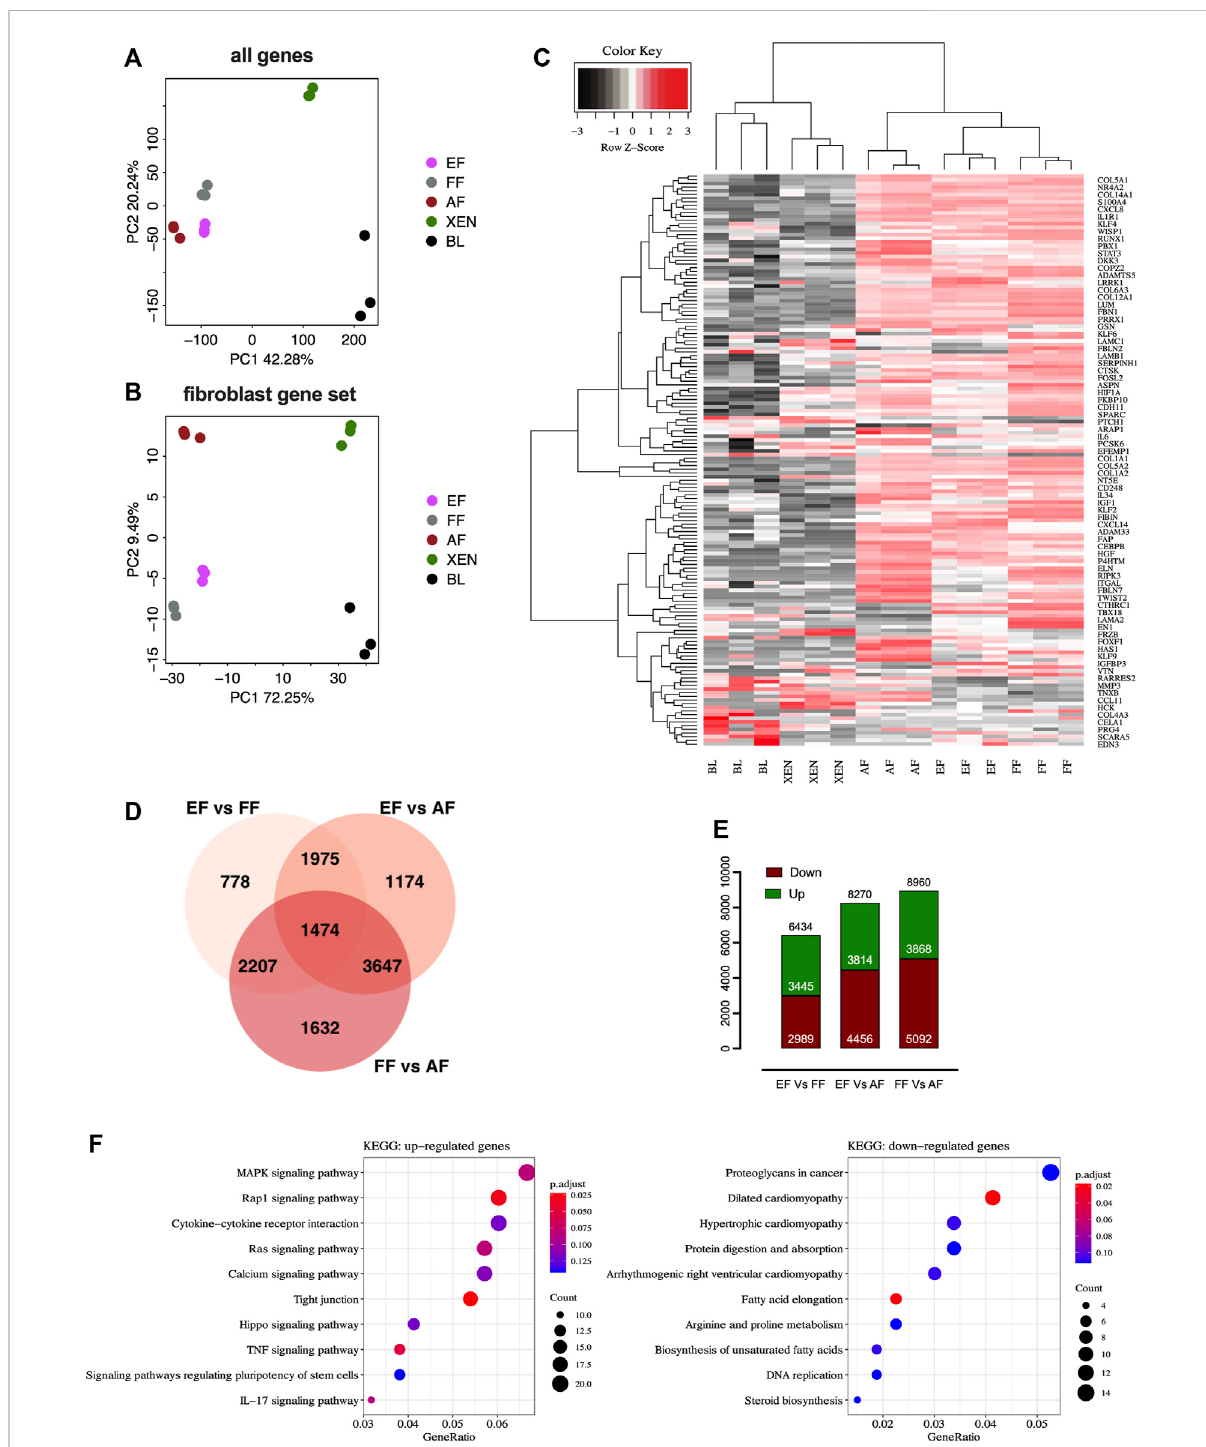
FIGURE 2 RNAseq analysis of fi broblasts from different origins. Principal component analysis (PCA) plots of RNA-seq data based on (A) global gene expressionoracandidatelistof (B) fi broblastmarkergenes.ThetwoaxesPC1andPC2representthe fi rsttwoprincipalcomponentsidenti fi edbythe analysis. Each color code denotes different cell types in the scheme in the middle of the plots. (C) Gene expression heatmap of 156 genes in the fi broblast gene-set. (D) Venn diagram showing that numbers in each segment represent differentially expressed genes (DEGs) that are not shared, and in overlapping segments-the shared DEGs among the fi broblasts. (E) Bar plot of the number of differentially expressed genes (DEGs). Downregulated genes are depicted in red, and upregulated genes are depicted in green. (F) KEGG pathway enrichment analysis of DEGs. Bubble